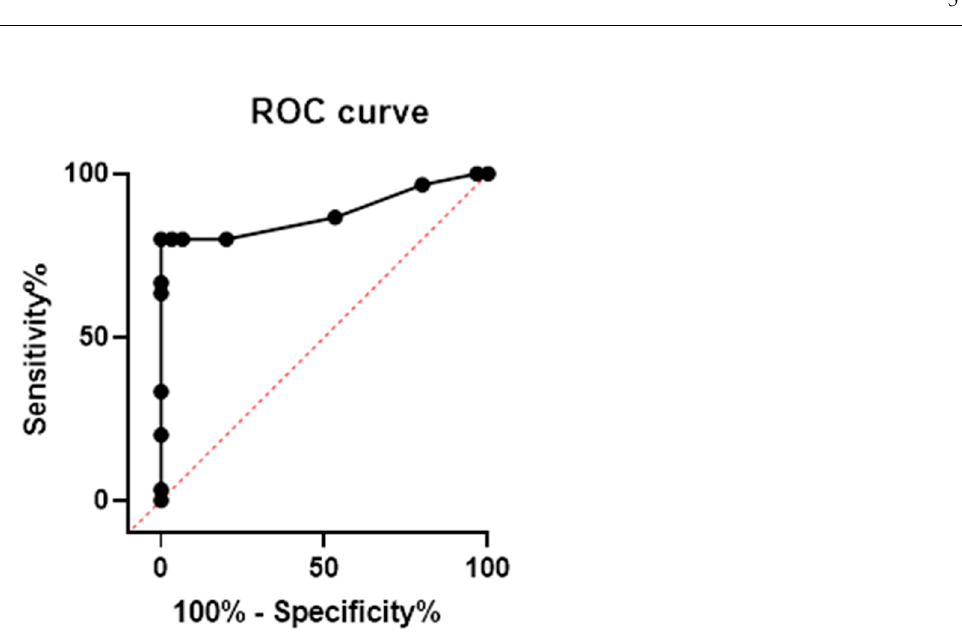
Figure 1. Receiver operating characteristic Curve analysis of PSQ for diagnosis of moderate-to severe OSA. PSQ showed a good accuracy in predicting moderate-to-severe OSA with an AUC of 0.879 (95% CI 0.779–0.975, p < 0.0001). The cut-off of 0.65 showed a sensitivity of 80% and a specificity of 100%. Legend: ROC: receiver operating characteristic.